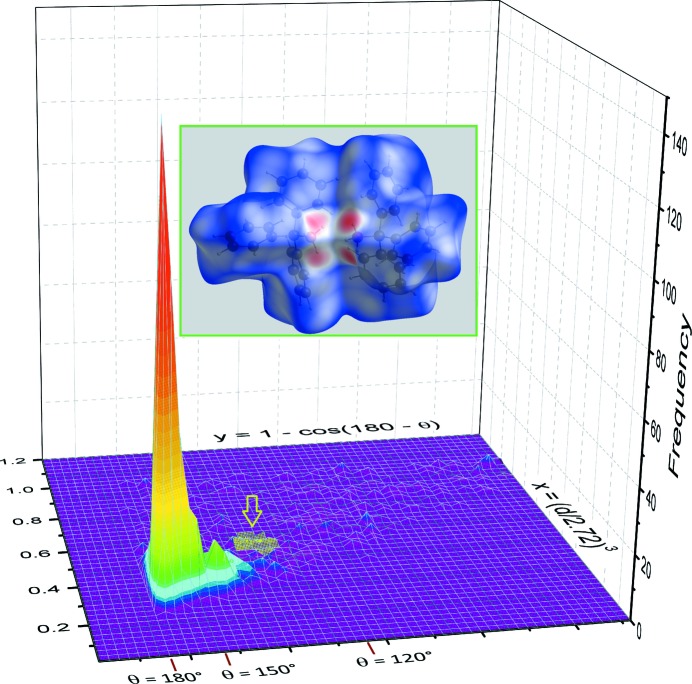
Histogram of the O—H⋯O inter­molecular hydrogen-bond geometry in the crystal structures of tertiary alcohols, in spherical polar coordinates (x, y), with the CSD frequency shown in the third dimension (OriginLab, 2012 ▸). A log10 rainbow colour scheme is used to highlight small frequencies. Some values for the O—H⋯O angles θ are reported on axis y, for reference. Note the similarity of the distribution with that depicted in the CCDC article about the directionality of hydrogen bonds (Wood et al., 2009 ▸; see Fig. 2 ▸ in this article). The green patch marked with an arrow in the (x, y) plane defines the area for hydrogen bonds in the A/B tetra­meric cluster of the title compound at 153 K. The inset shows the Hirshfeld surface mapped over d (−1 to 1 Å) for the A/B mol­ecules at 153 K (Turner et al., 2017 ▸); each of the four red patches on the surface is related to a single node for the topological graph G(4,6) of the A/B tetra­mer (see Fig. 3 ▸).